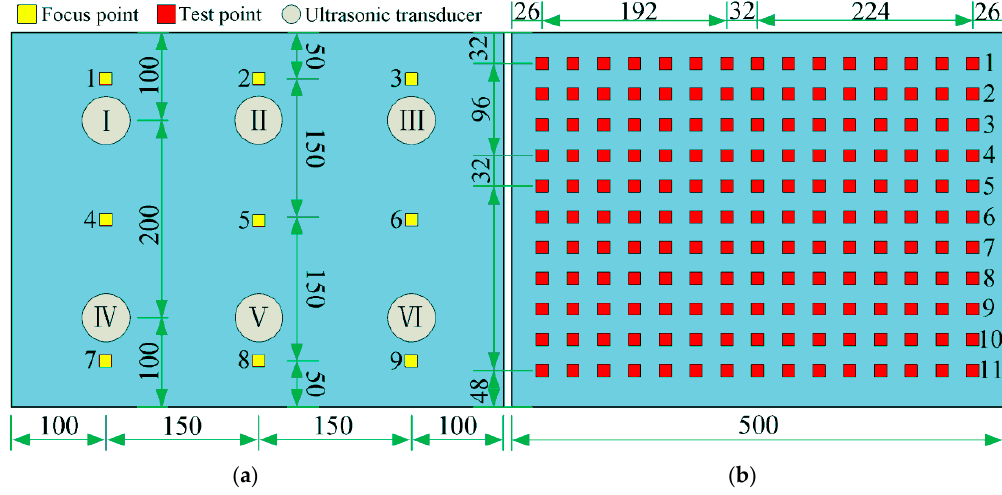
Figure 4. Ultrasonic array focusing model and test points. ( a ) Focus points and ultrasonic transducers, ( b ) distribution of test points.